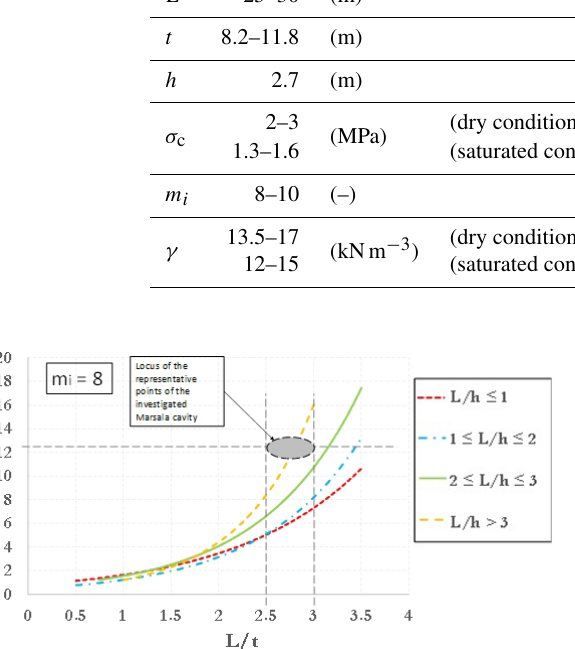
Table 3. Geometrical and mechanical parameters and adopted values for stability chart application to the Marsala underground quarry. Geometrical and mechanical parameters from Adopted values for stability chart speleological surveys and material characterization